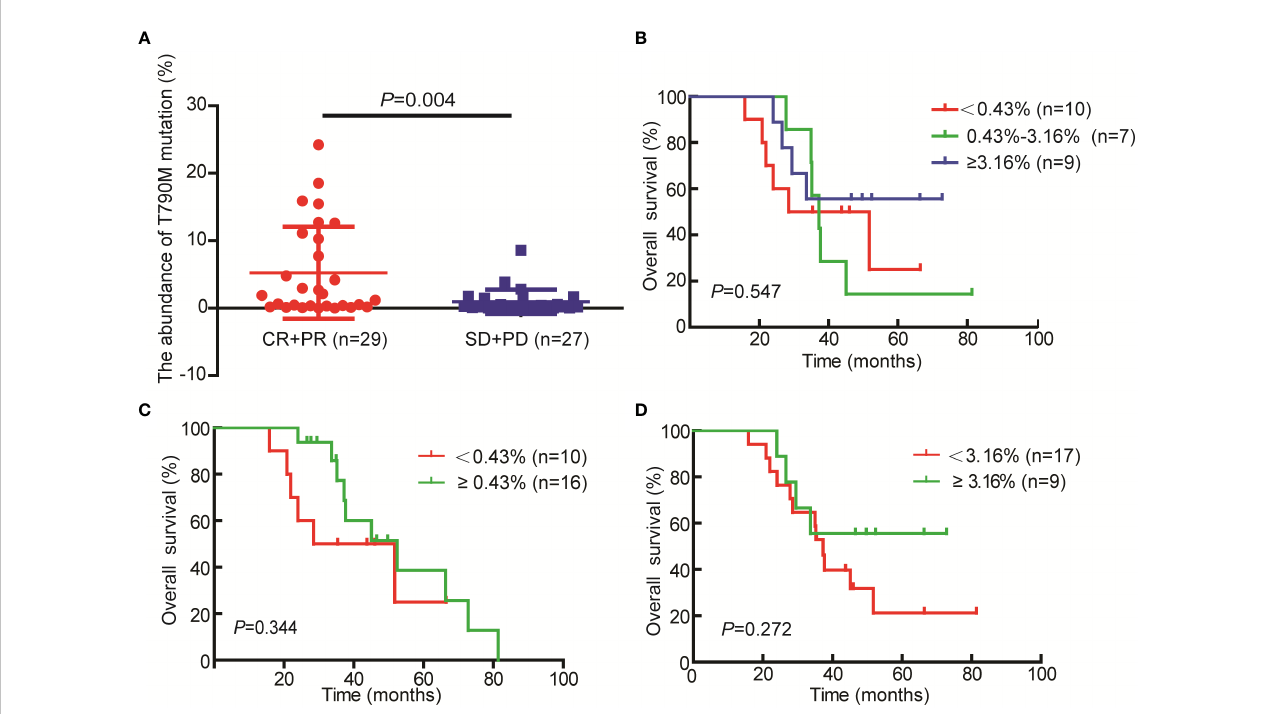
FIGURE 5 Relationship between T790M mutation abundances and the response to third-generation EGFR -TKI and the prognosis of non-small cell lung cancer (NSCLC) patients. (A) T790M mutation abundance in the CR+PR and SD+PD groups. (B – D) Kaplan – Meier curves were used to assess the relationship between T790M mutation abundance and the overall survival of patients with NSCLC.